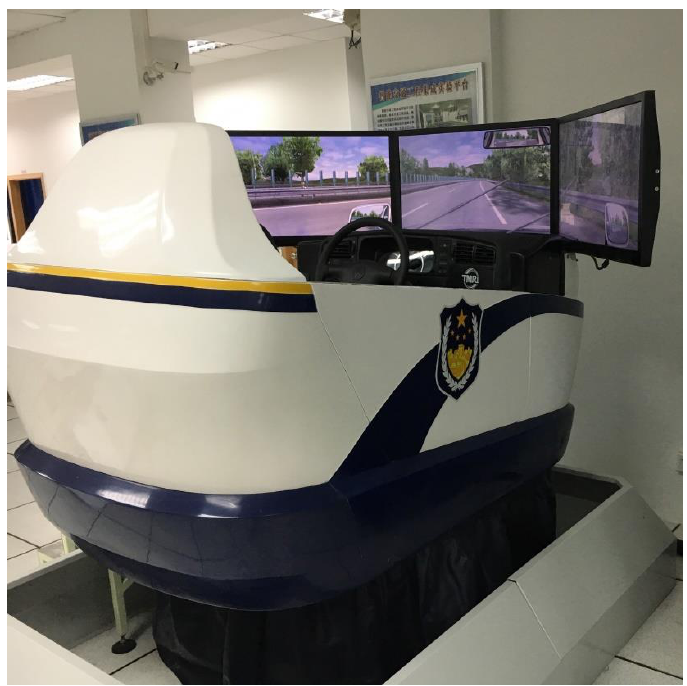
Figure 1. Fix-based driving simulator in the South China University of Technology.